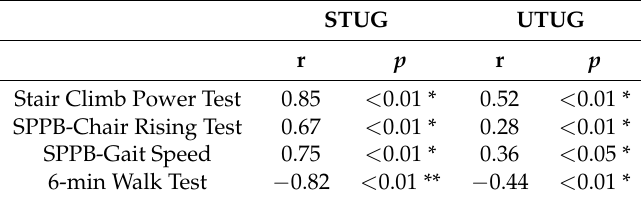
Table 7. Correlation coefficients of the Standard TUG duration (STUG) and Unsupervised TUG duration (UTUG) with other geriatric tests like for example the chair rising and gait speed of the Short Physical Performance Battery (SPPB). Significant results are marked with an asterisk (*).